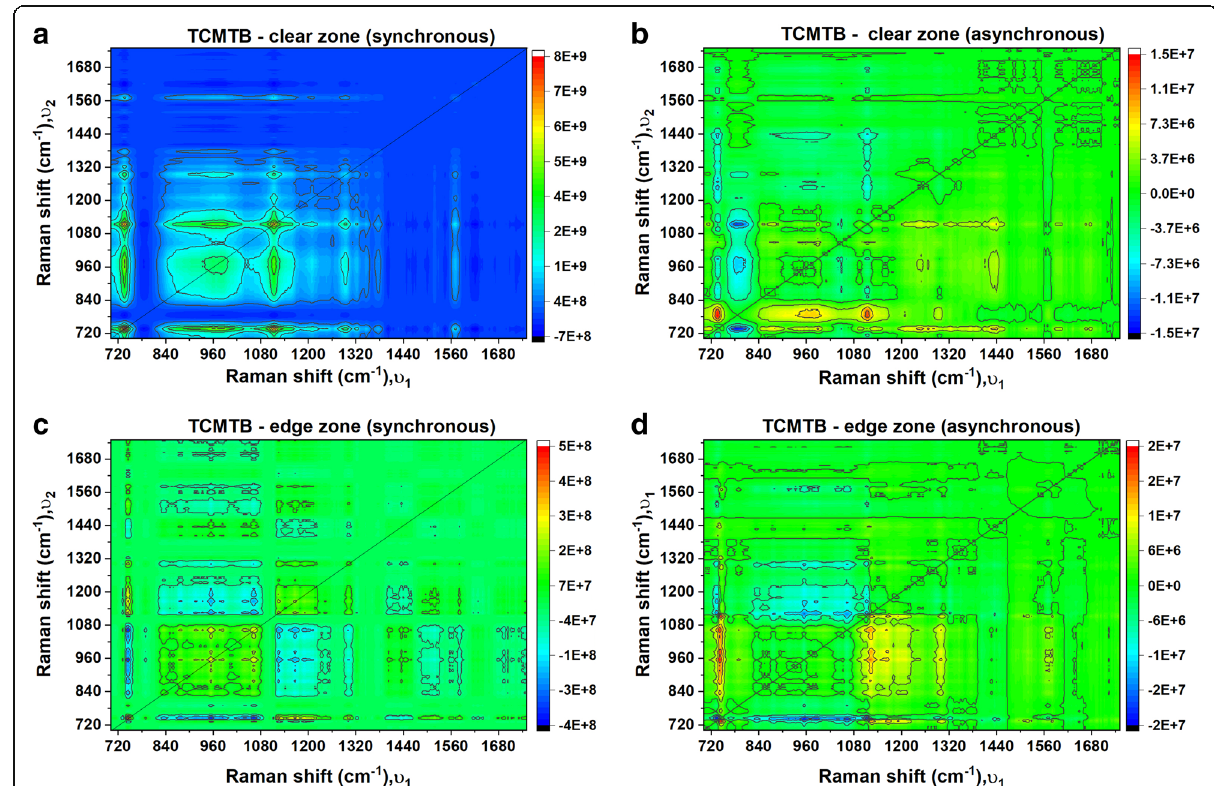
Fig. 6 Synchronous ( a , c ) and asynchronous ( b , d ) correlation spectra of clear and outer edge zone of bacterial cells exposed to TCMTB ranging concentrations from 0 to 30%. (Intensity colour scale on the